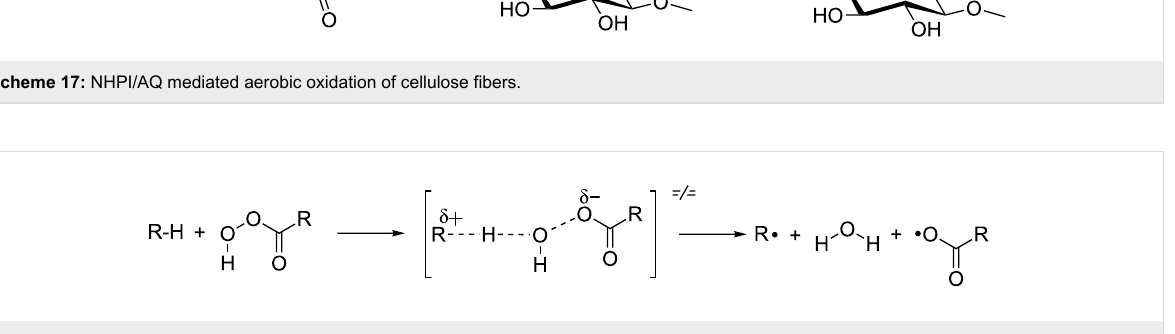
Scheme 18: Molecule-induced homolysis by